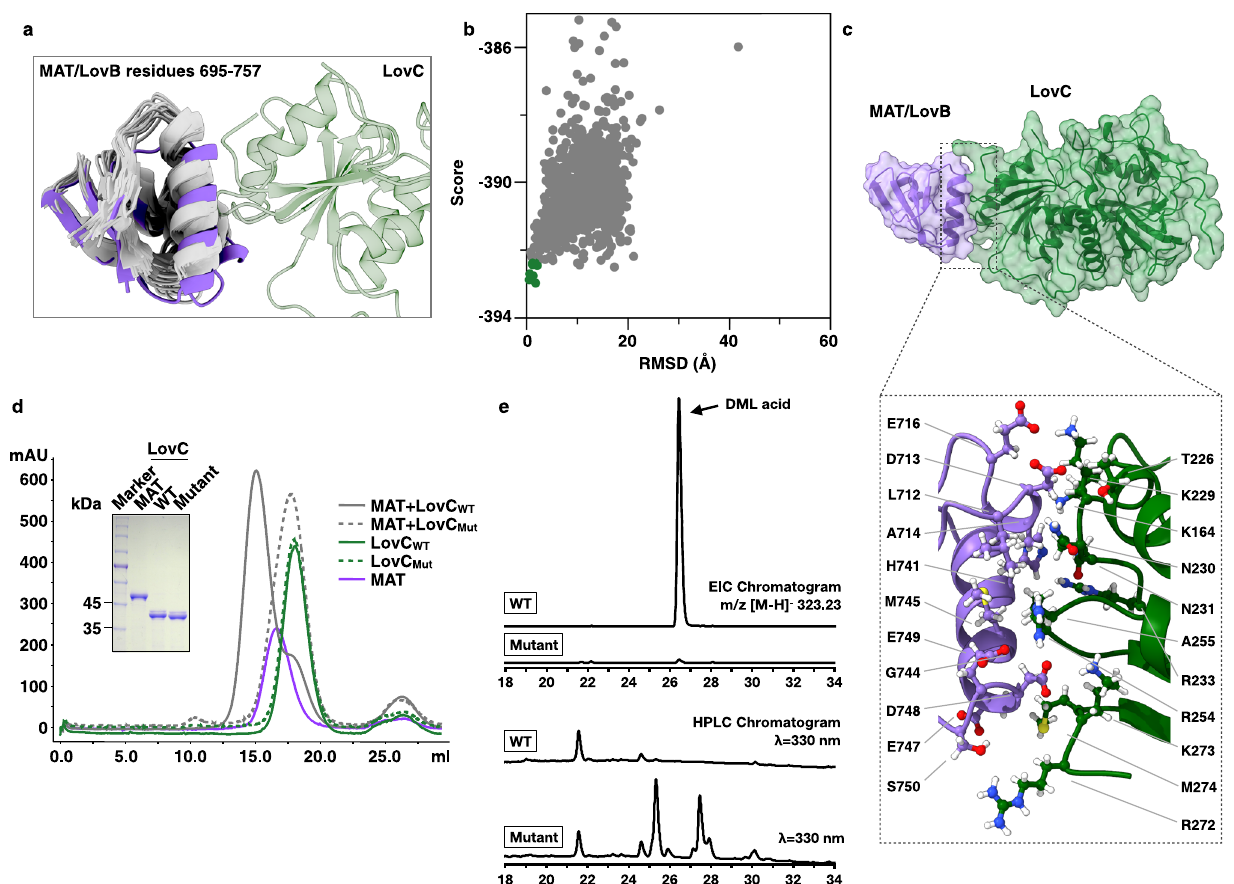
Fig. 4 Interaction between LovB and LovC is essential for the synthesis of DML. a Nineteen models built by RosettaCM were chosen for protein docking simulation with LovC. Residues 695 – 757 (part of the MAT domain) are shown. Purple color denotes the successful docked model. b Energy funnel for MAT/LovB – LovC docking analysis. The plot of score vs. rmsd shows the ten lowest-energy decoys (dark green) with rmsd <2.2 Å . c LovB – LovC interface. Top, view of the isolated electron density of MAT/LovB and interacting LovC with fi tted molecular models. Bottom, close-up view of the interface between MAT/LovB and LovC (amino acids within 4 Å ). d Size exclusion chromatography pro fi les for the interaction between LovC and the MAT domain of LovB. The LovC mutant pro fi le is indicated by a dashed line. Elution of the component protein(s) is marked in color. One representative gel panel from at least three independent experiments shows the puri fi ed MAT domain of LovB, LovC, and the LovC mutant detected by SDS-PAGE. Source data is provided as a Source Data fi le. e HPLC traces showing the products of the in vitro reactions catalyzed by LovB with LovC or LovC mutant. LovG was included in the reaction mixture to release the fi nal products. The DML acid has calculated and experimentally determined m / z [M − H] − values of 323.23 and 323.22, respectively. Top, the extracted-ion chromatogram pro fi le; bottom, the HPLC chromatogram pro fi le at λ = 330